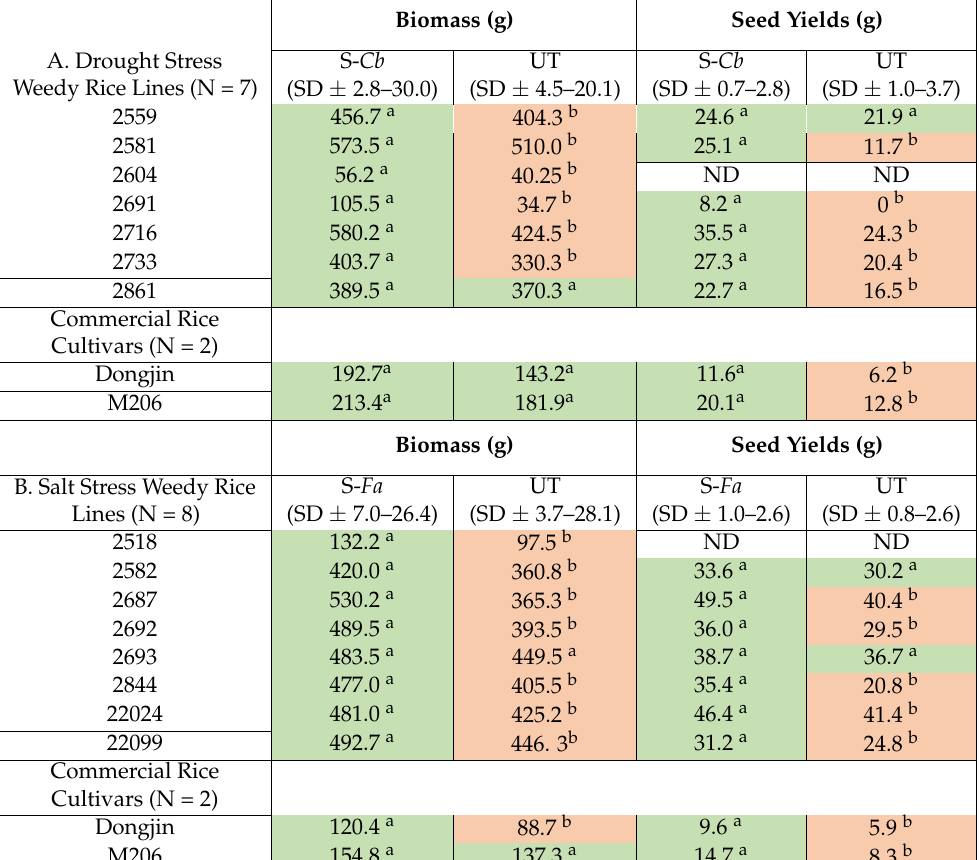
Table 1. Greenhouse drought and salt stress tolerance in mature weedy rice lines and commercial cultivars. Biomass (g) Seed Yields